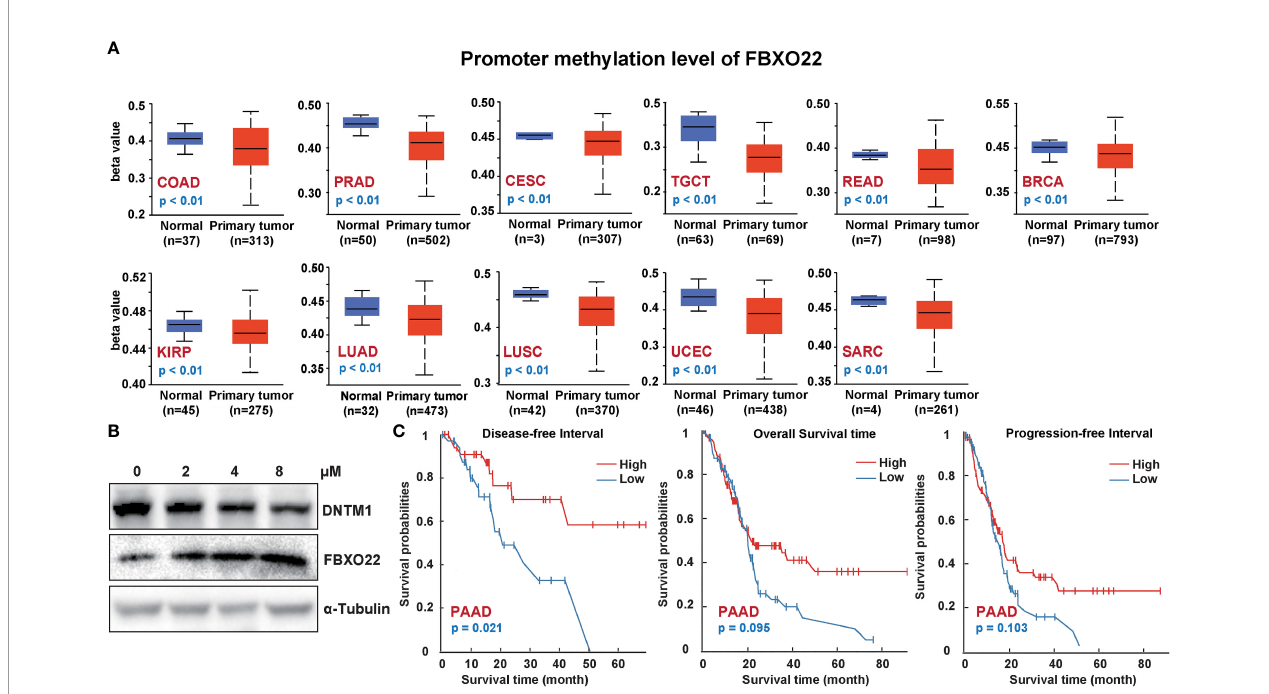
FIGURE 5 | FBXO22 DNA methylation in different cancer types. (A) FBXO22 methylation levels in COAD, PRAD, CESC, TGCT, READ, KIRP, LUAD, LUSC, BRCA, UCEC, and SARC. (B) FBXO22 expression was decreased in A549 cells treated with different concentrations of SGI-1027, a DNA methyltransferase inhibitor. (C) Potential correlation between FBXO22 methylation and overall, progression-free, and disease-speci fi c